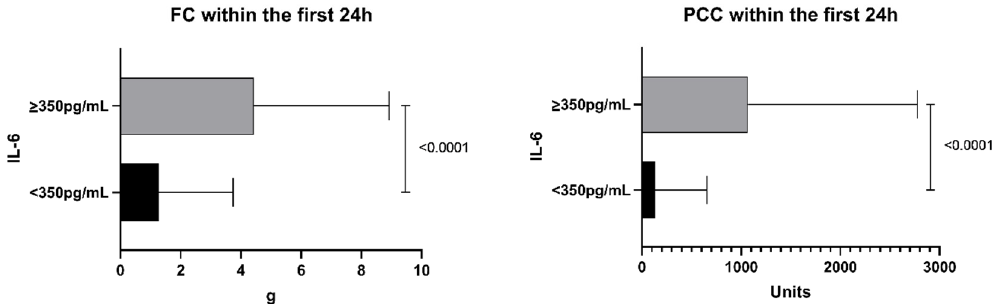
Figure 2. Coagulation therapy of patients in the high-IL-6 group ( ≥ 350 pg/mL) and the low-IL-6 group (<350 pg/mL)). IL-6, interleukin 6; FC, fibrinogen concentrate; PCC, prothrombin complex concentrate.